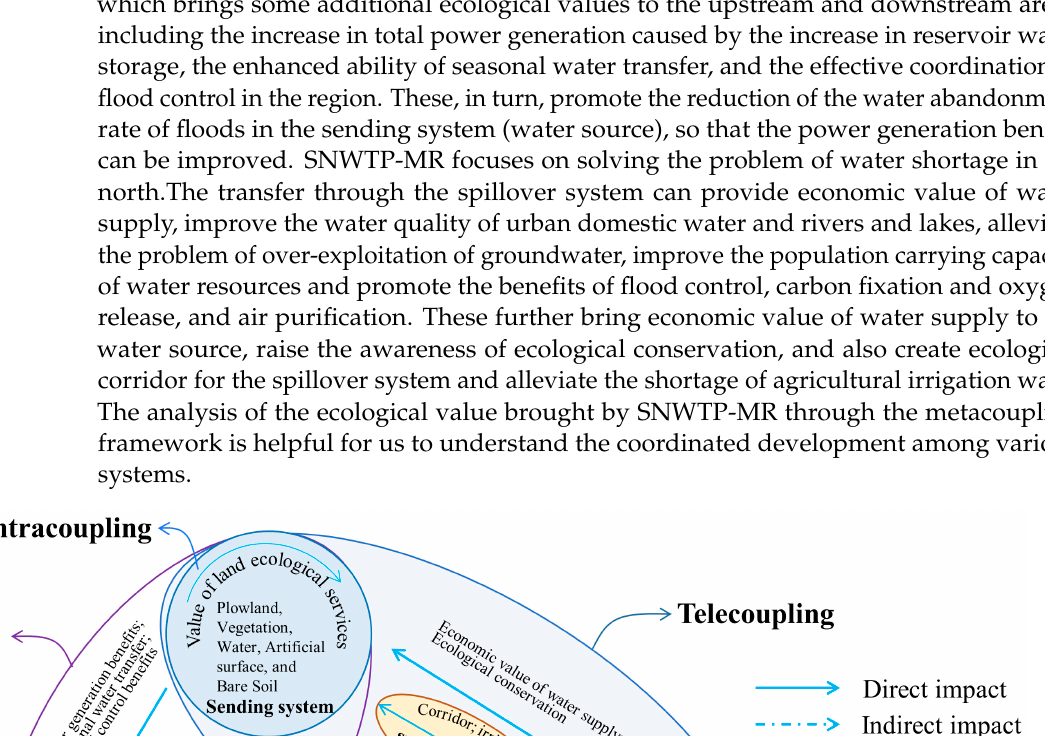
Table 8. The ecological risk index of intracoupling.